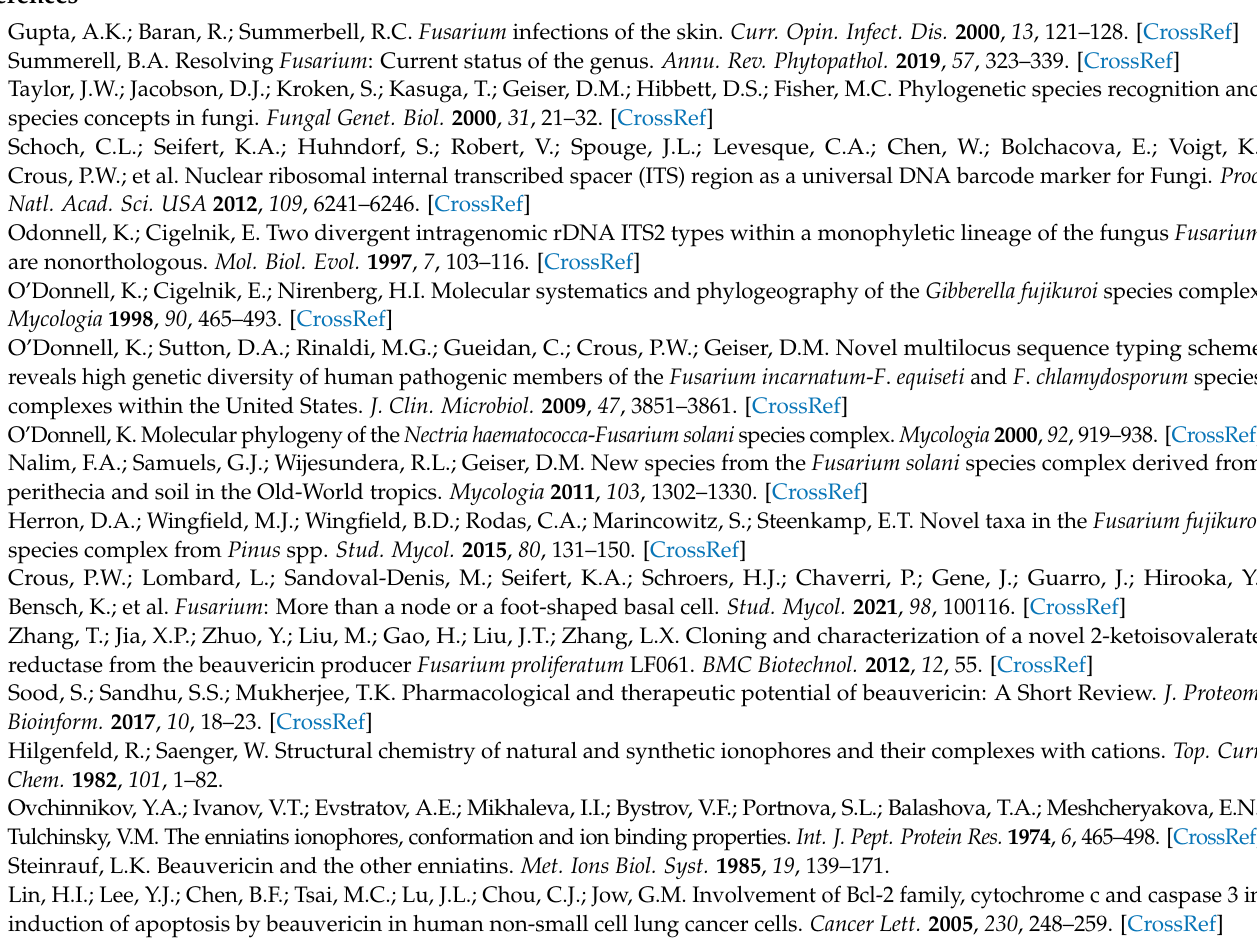
(r) F. grosmichelii NFCCI 3243; Table S1: GenBank Accession No. and other details of the isolates used in the phylogenetic